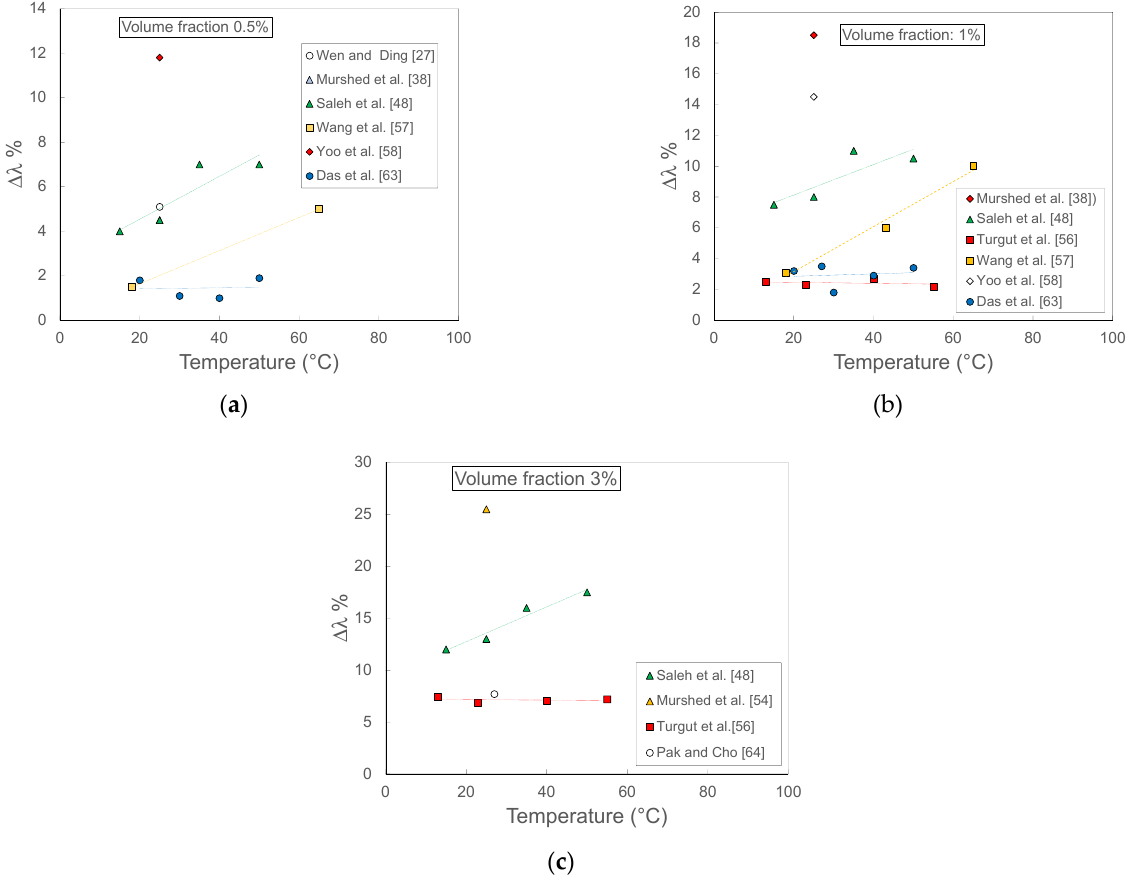
Figure 11. Thermal conductivity enhancement for TiO 2 -water nanofluids measured by different laboratories as a function of temperature at three different nanoparticles volume fractions: ( a ) 0.5%; ( b ) 1%; ( c ) 3%.